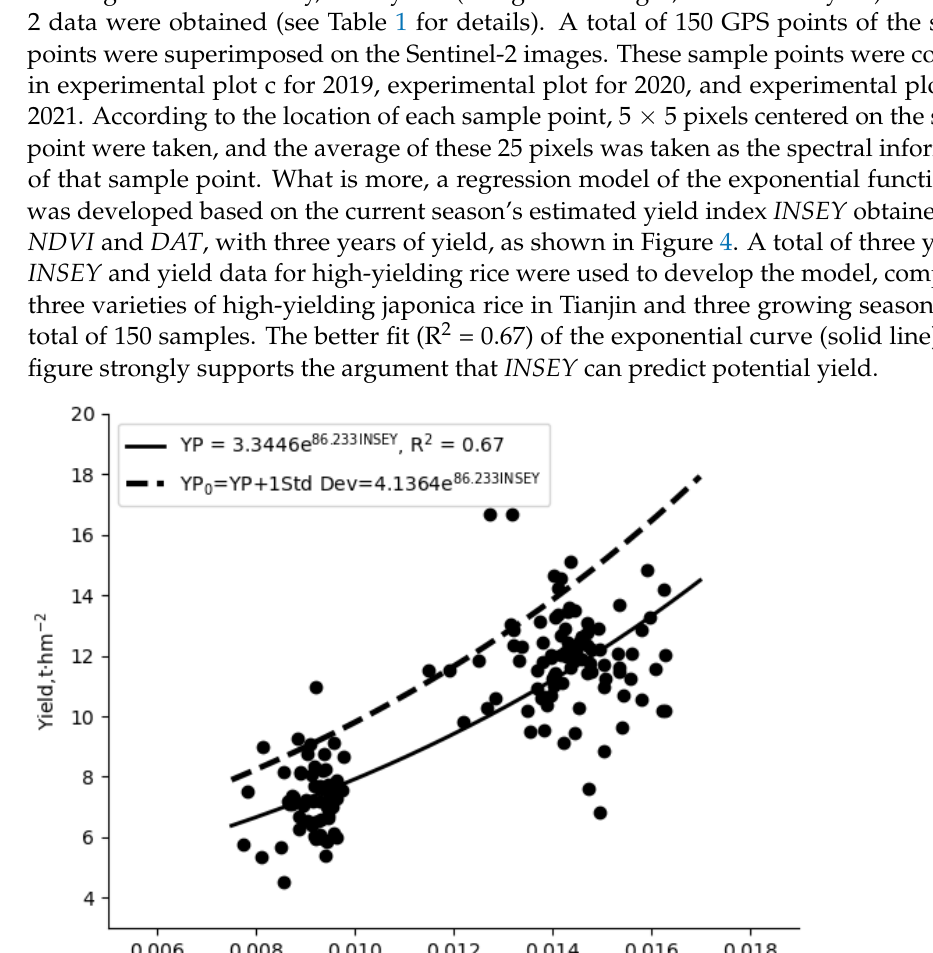
Figure 5. Comparison chart of predicted yield and actual yield. 3.2. Construction of a Model for the Prediction of Grain Nitrogen Content The current yield-based NFOA is based on setting a target yield at the beginning of the rice growing season based on the average GNC and NUE to estimate N fertilizer re- quirements. Since the empirical average GNC is subject to large errors, this experiment is